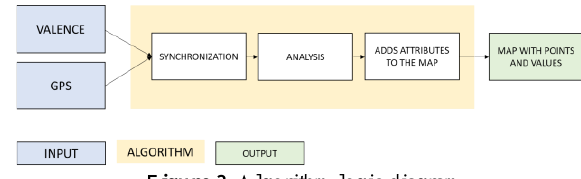
Figure 3. Algorithm logic diagram.